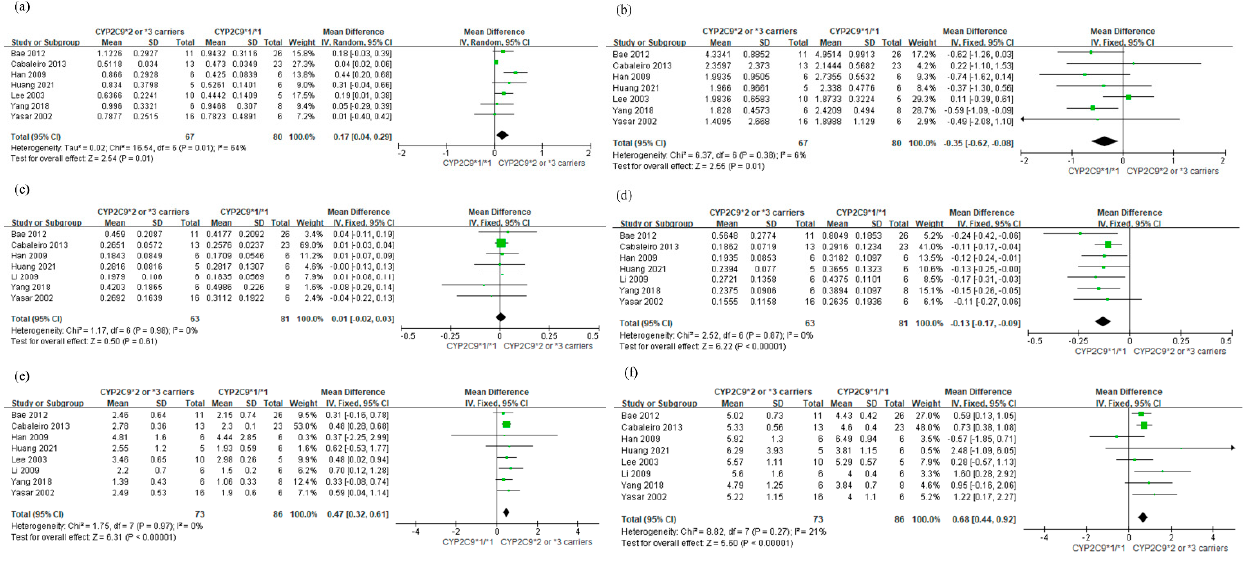
Figure 2. Forest plot comparing the mean difference between CYP2C9*2 or *3 carriers and CYP2C9*1/*1 . ( a ) AUC 0- ∞ of losartan ( μg ∙ h/mL ), ( b ) AUC 0- ∞ of E-3174 ( μg ∙ h/mL ), ( c ) C max of losartan ( μg/mL ), ( d ) C max of E-3174 ( μg/mL ), ( e ) half-life of losartan (h), ( f ) half-life of E-3174 (h).